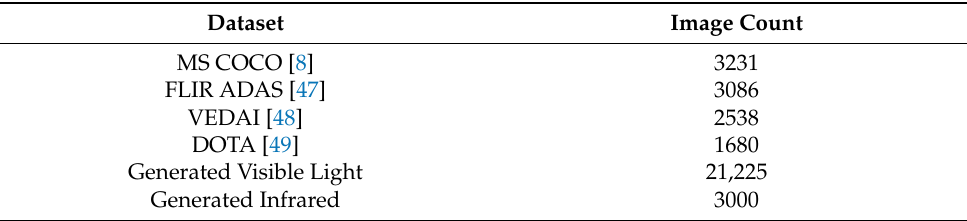
Table 2. Number of used images in each dataset. Images containing small-sized objects in human- and vehicle-related categories are sampled for